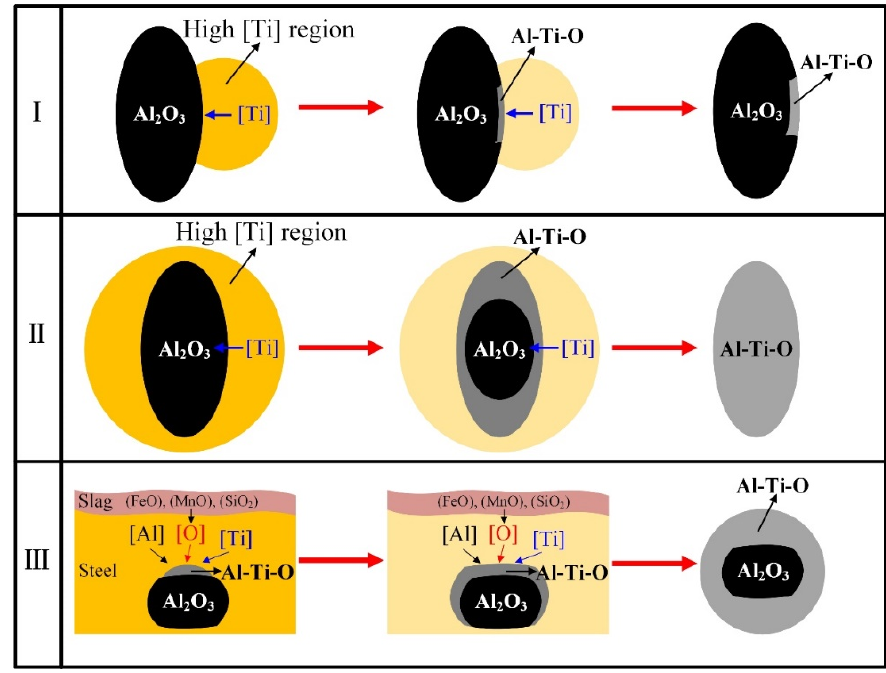
Figure 14. Formation mechanisms of Al 2 O 3 ·TiO x inclusions during RH refining and tundish pro- cesses. ( I ) first formation mechanism of Al 2 O 3 ·TiO x inclusions, ( II ) second formation mechanism of Al 2 O 3 ·TiO x inclusions, ( III ) third formation mechanism of Al 2 O 3 ·TiO x inclusions